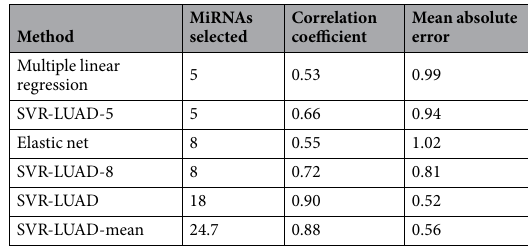
Table 1. Prediction performance comparison of SVR-LUAD.